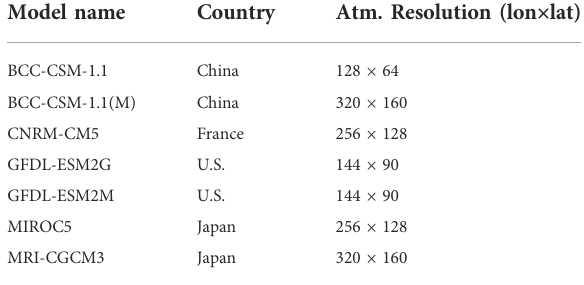
TABLE 1 CIMP5 models used to drive the YIBs